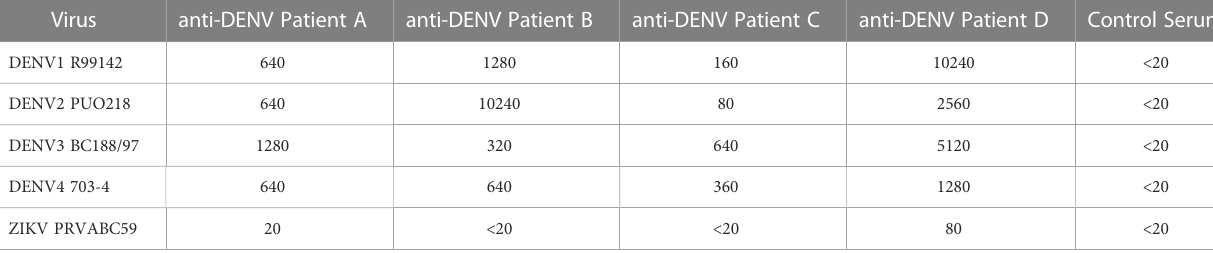
TABLE 1 Serological characterization of donor blood.